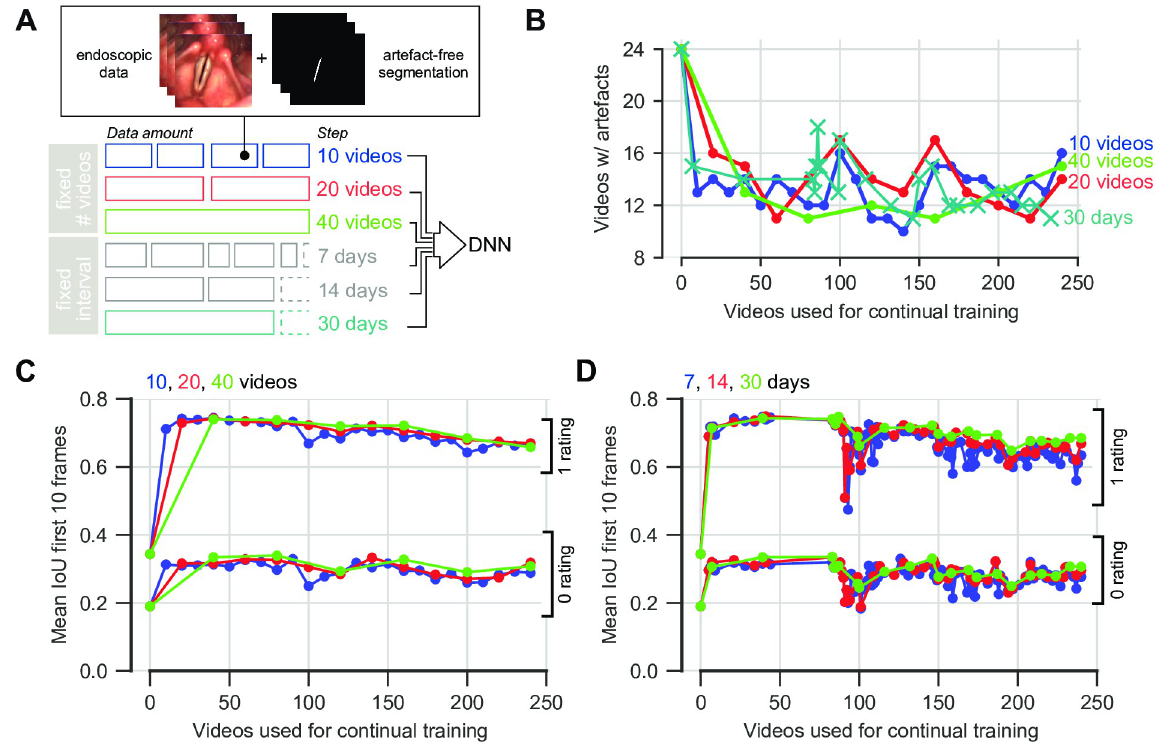
Fig 5. Continual training alleviates segmentation artifacts. A: Continual training strategies. B: Reduction of artifacts depending on continual learning strategy. C: IoU score of the first ten frames of the evaluated data after continual learning with a fixed amount of videos. D: Same as in C, but with a fixed time